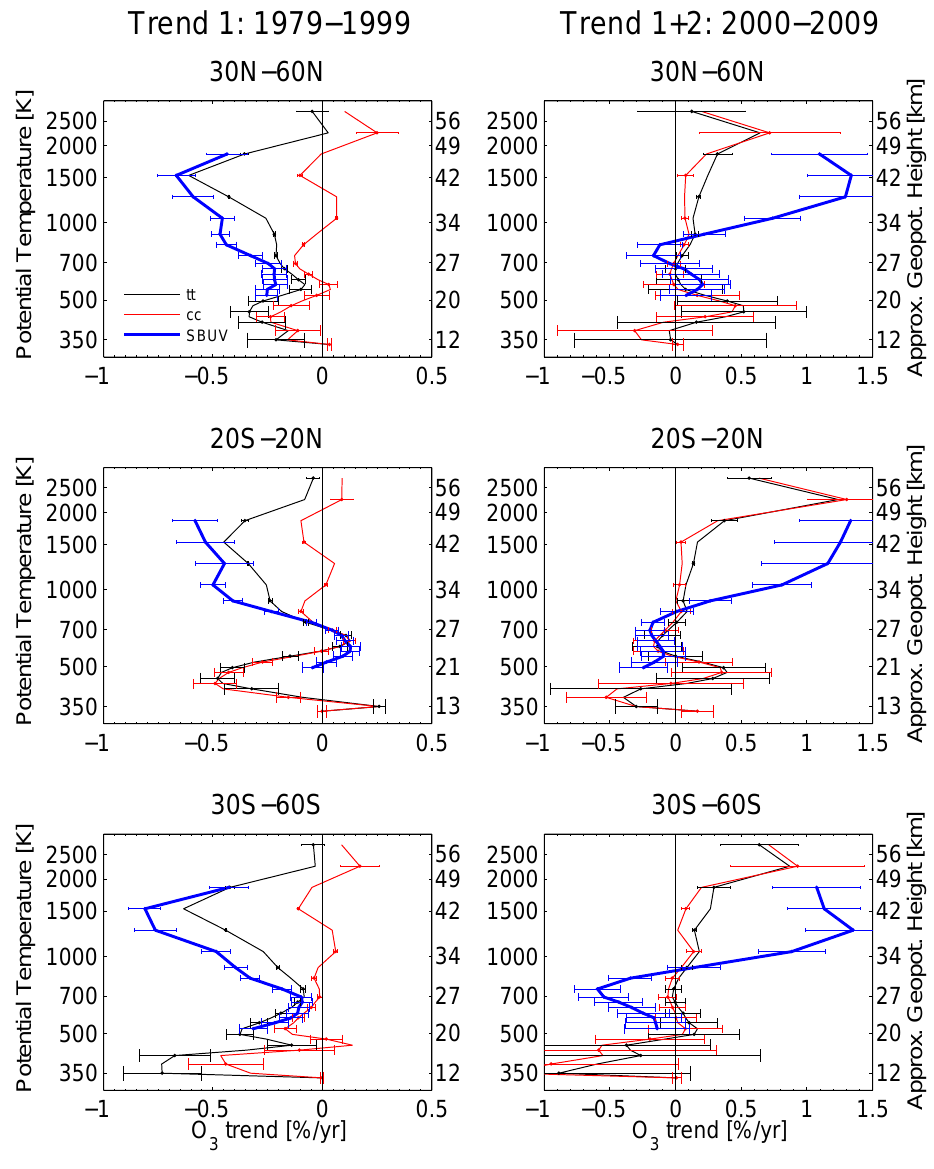
Fig. 10. Modelled ozone number density trends as compared to SBUV ozone trends, in the period 1979–1999 (left), and 2000–2009 (right). Trends from model runs with time-dependent chemistry and polar chemistry ( tt , black line) and constant chemical conditions ( cc , red line) are shown. Trends are given in percent of 1980 values per year. Error bars represent the 1 σ variance as obtained from the residuals of the linear